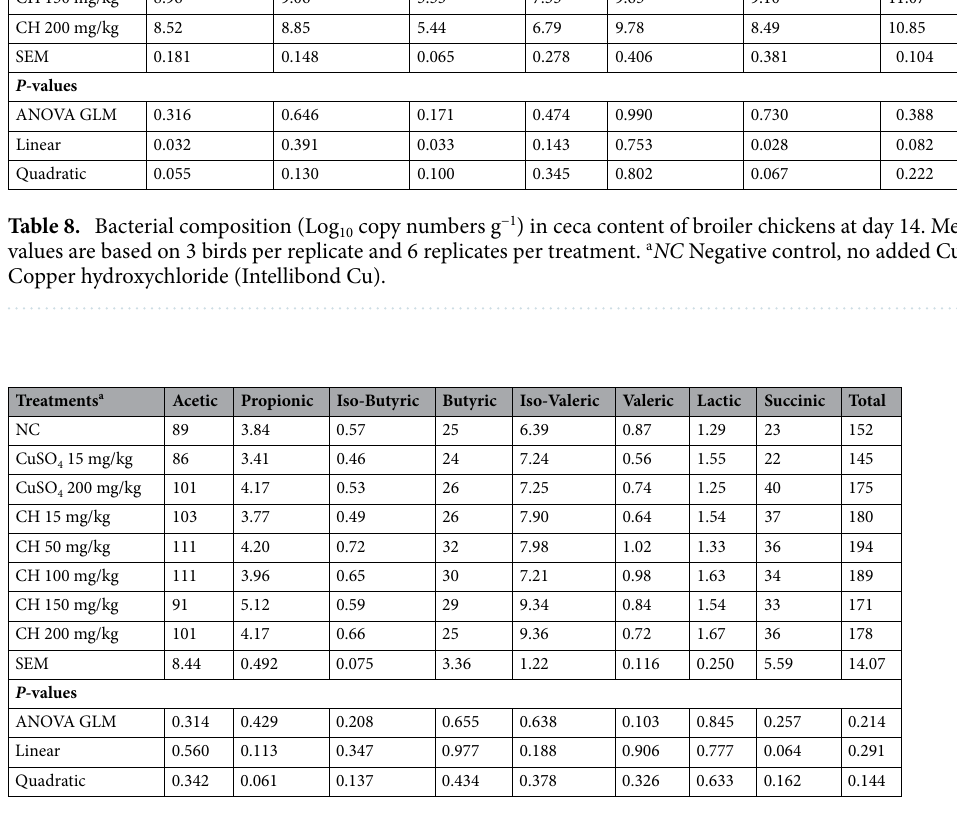
Table 9. Concentration of short chain fatty acids (μmol g −1 digesta) in ceca content of broiler chickens on day 14. Mean values are based on 3 birds per replicate and 6 replicates per treatment. a NC Negative control, no added Cu, CH Copper hydroxychloride (Intellibond